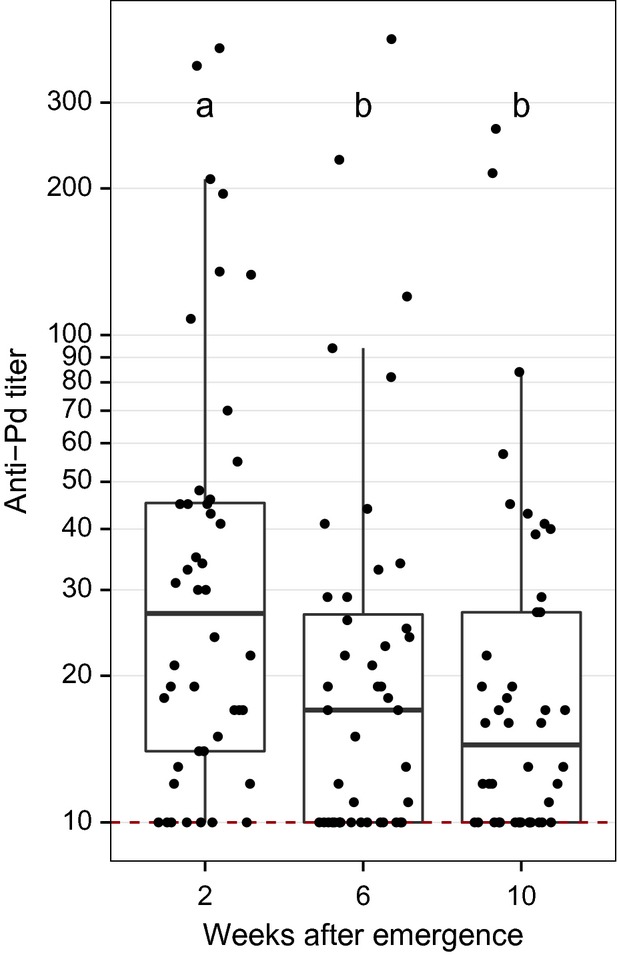
Comparison of anti-Pd antibody titers in 44 little brown myotis (Myotis lucifugus) collected from Pd-negative caves cutaneously inoculated with Pd and hibernated in captivity for 5 months. Anti-Pd titers were highest shortly after the end of hibernation and then declined. Data are presented with quartiles, median (black line), and whiskers that represent 1.5 times the interquartile range. Titers ≤ 10 are considered negative for Pd reactive antibodies. Titers differed significantly between weeks not sharing common letters (P < 0.05).